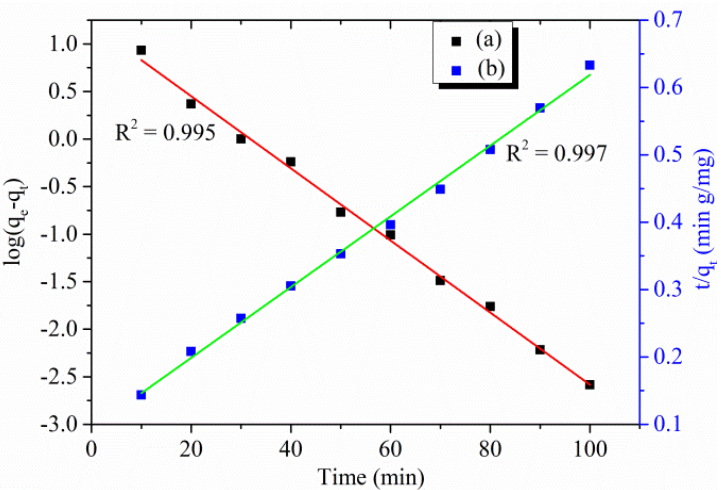
Figure 8. Adsorption kinetics parameter ( a ) PFO, and ( b ) PSO for RO16 adsorption by Cu(I)-PANI composite (initial concentration, pH, dosage, contact time, and volume of solution are 100 mg/L, 4, 0.06 g/L, 100 min, and 100 mL,